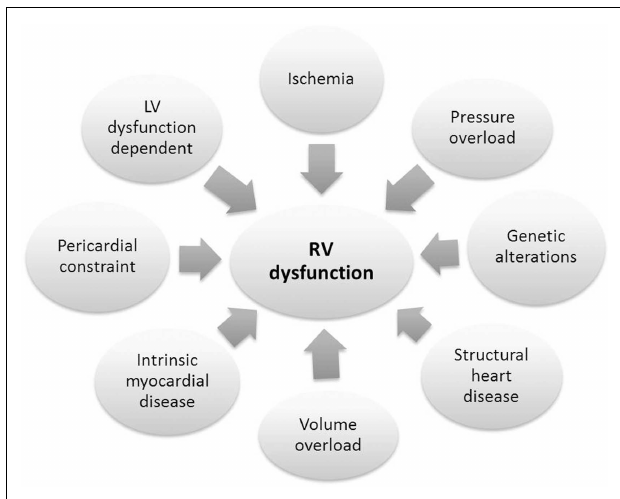
FIGURE 2 | Main mechanisms of right ventricular dysfunction